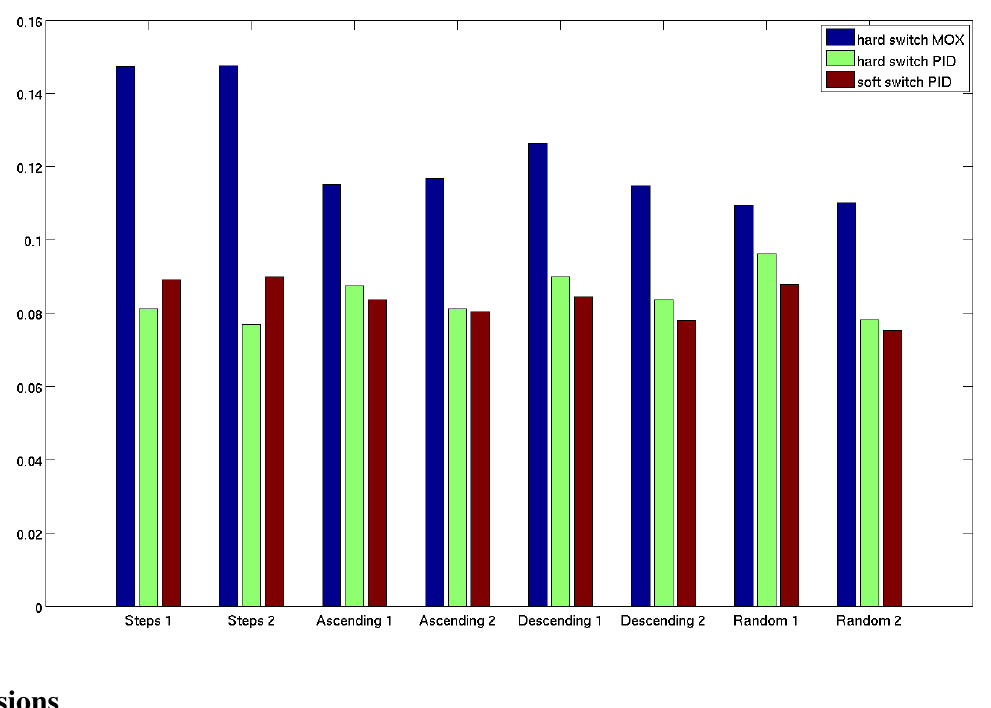
Figure 14. Normalized Root Mean Square error for each experiment, averaged over all